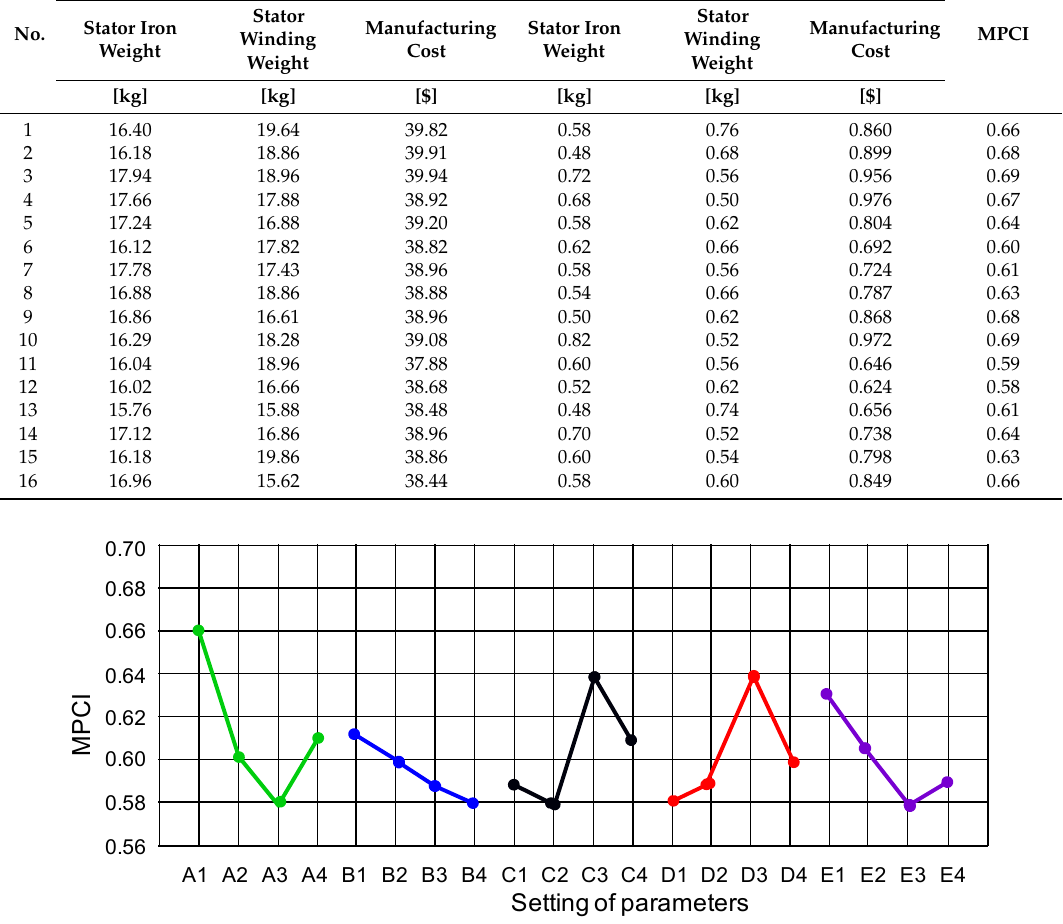
Figure 3. The MPCI values for five control factors with respect to the corresponding levels.